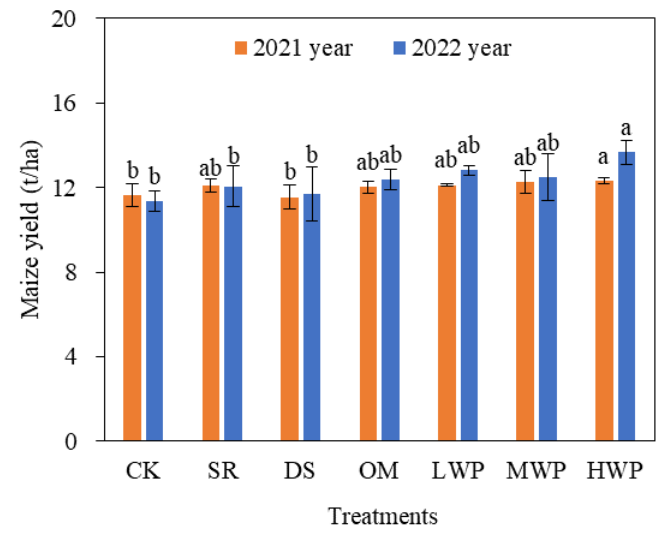
Figure 6. Change in maize yield under different treatments. Different lowercase letters in the box denote significant differences between different treatments of the same year at p < 0.05, respectively.